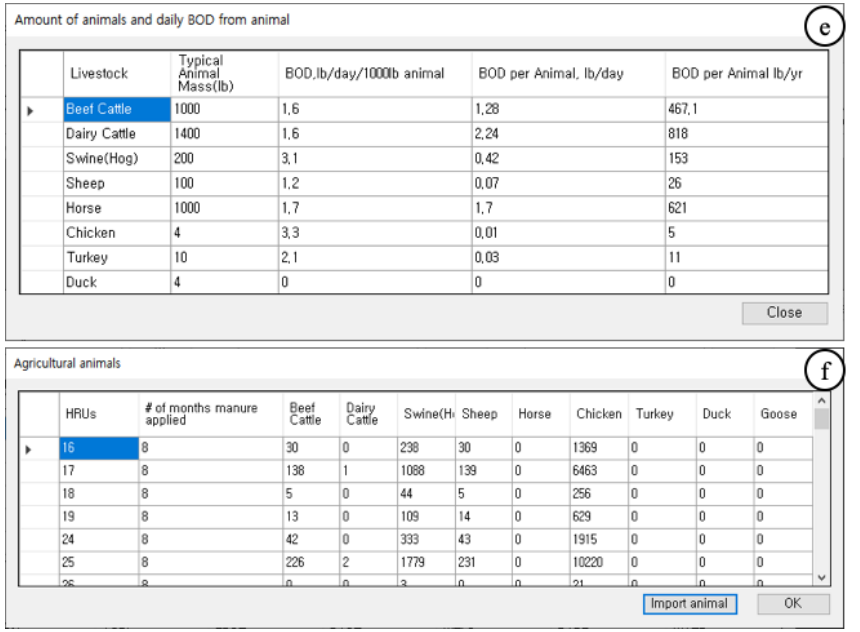
Figure 6. Supplementary GUIs for nutrient and livestock inputs for editing ( a ) nutrient concentration of direct runoff from agriculture and pastureland, ( b ) nutrient concentration of direct runoff from other land use types, ( c ) nutrient concentration of baseflow, ( d ) nutrient concentration of sediment, and ( e ) number of animals and daily BOD per animal, and ( f ) for entering number of months during which manured is applied and number of animals for each HRU.